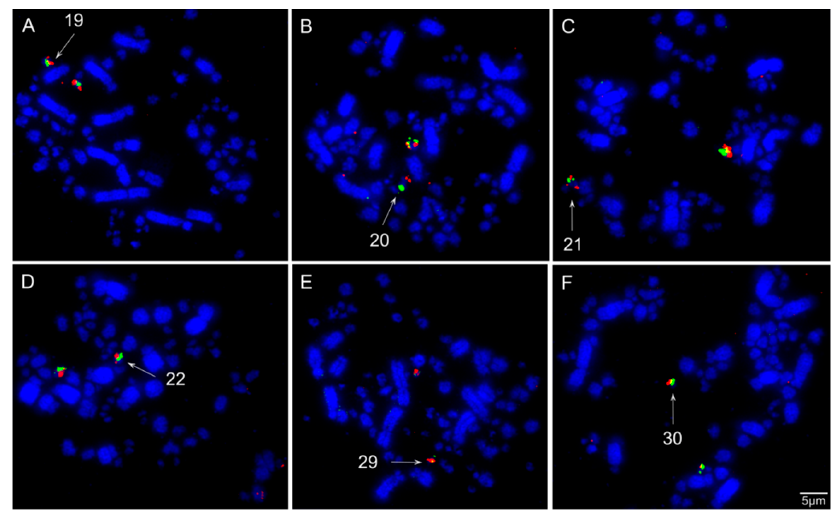
Figure 4. Representative FISH experiments using chicken (CH261) and zebra finch (TGMCBA) microchromosomes BAC probes in Sicalis flaveola : ( A ) chicken microchromosome 17 CH261 ‐ 42P16 (red) and TGMCBA ‐ 375I5 (green); ( B ) chicken microchromosome 18 CH261 ‐ 72B18 (red) and CH26 ‐ 60N6 (green); ( C ) chicken microchromosome 19 CH261 ‐ 10F1 (red) and CH261 ‐ 50H12 (green); ( D ) chicken microchromosome 20 TGMCBA ‐ 250E3 (red) and TGMCBA ‐ 341F20 (green); ( E ) chicken microchromosome 27 CH261 ‐ 28L10 (red) and CH261 ‐ 66M16 (green); ( F ) chicken microchromosome 28 CH261 ‐ 72A10 (red) and CH261 ‐ 64A15 (green).